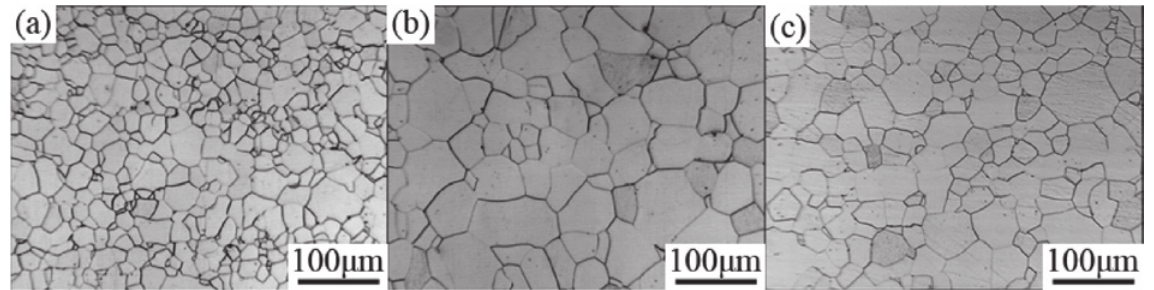
Fig. 5: Optical microstructures of annealed cold-rolled steel sheets: (a) steel 1; (b) steel 2; (c) steel 3